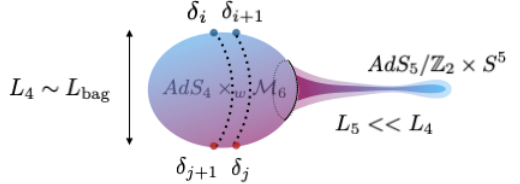
Figure 3 . The geometry of interest: the compact bag is attached to a semi-infinite throat with radius hierarchically smaller than the size of the six-dimensional internal manifold. The fivebranes are found on the point singularities located at δ, ˆ δ